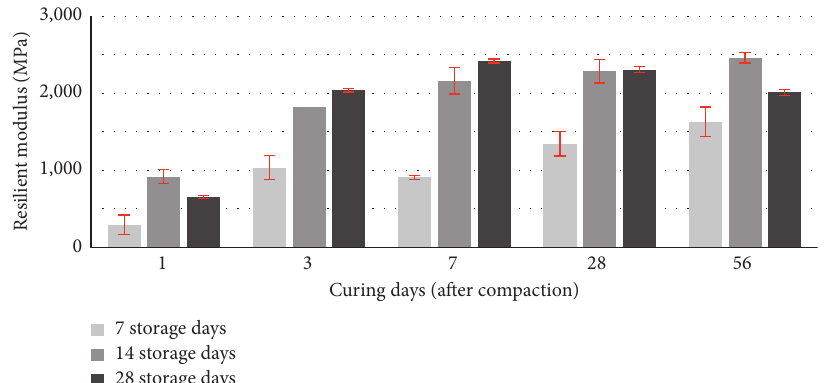
Figure 5: Resilient modulus after a storage period of loose mix during 7, 14, and 28 days and curing time and compaction of 1, 3, 7, 28, and 56 days.